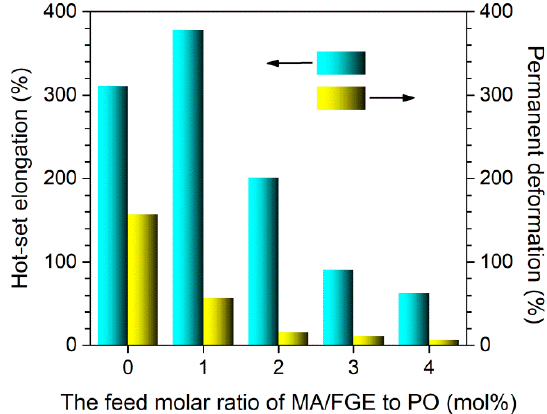
Figure 3. The hot-set elongation and permanent deformation of PPC and PPC-MFs.